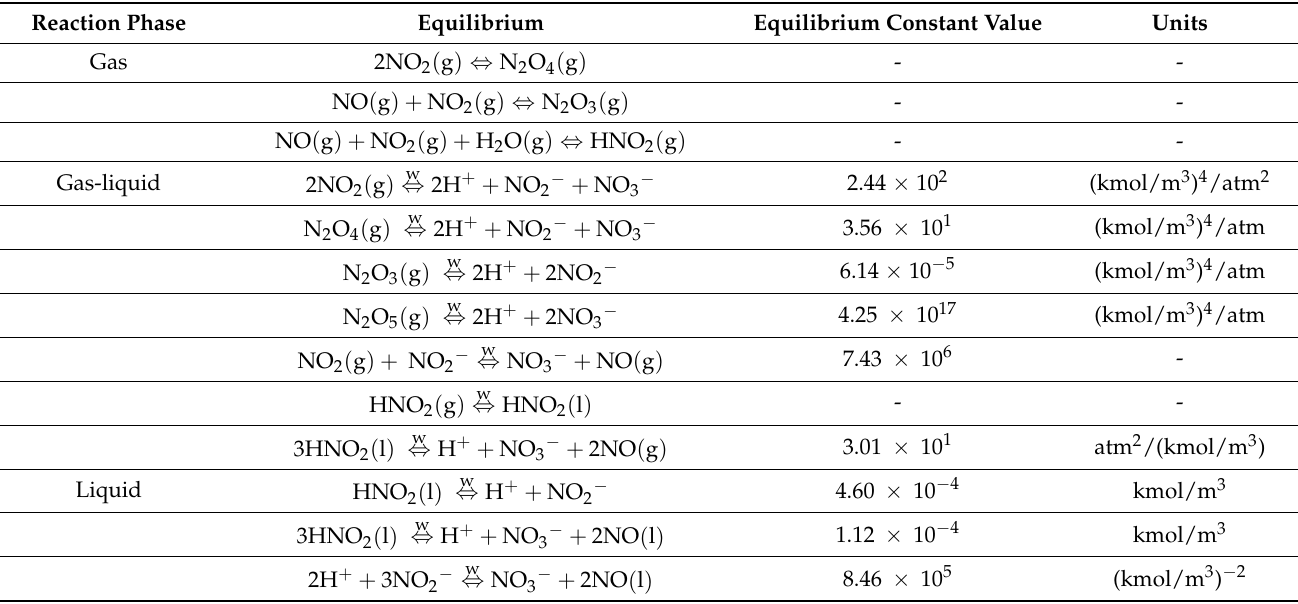
Table 5. Reactions of NOx absorption from gas phase to liquid phase [133].